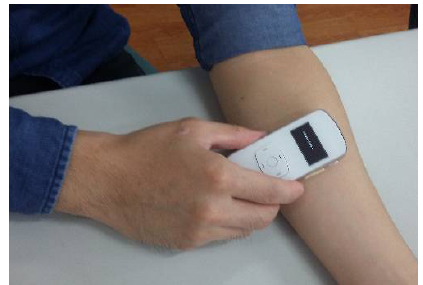
Figure 6. Measurement by the PPG sensor.